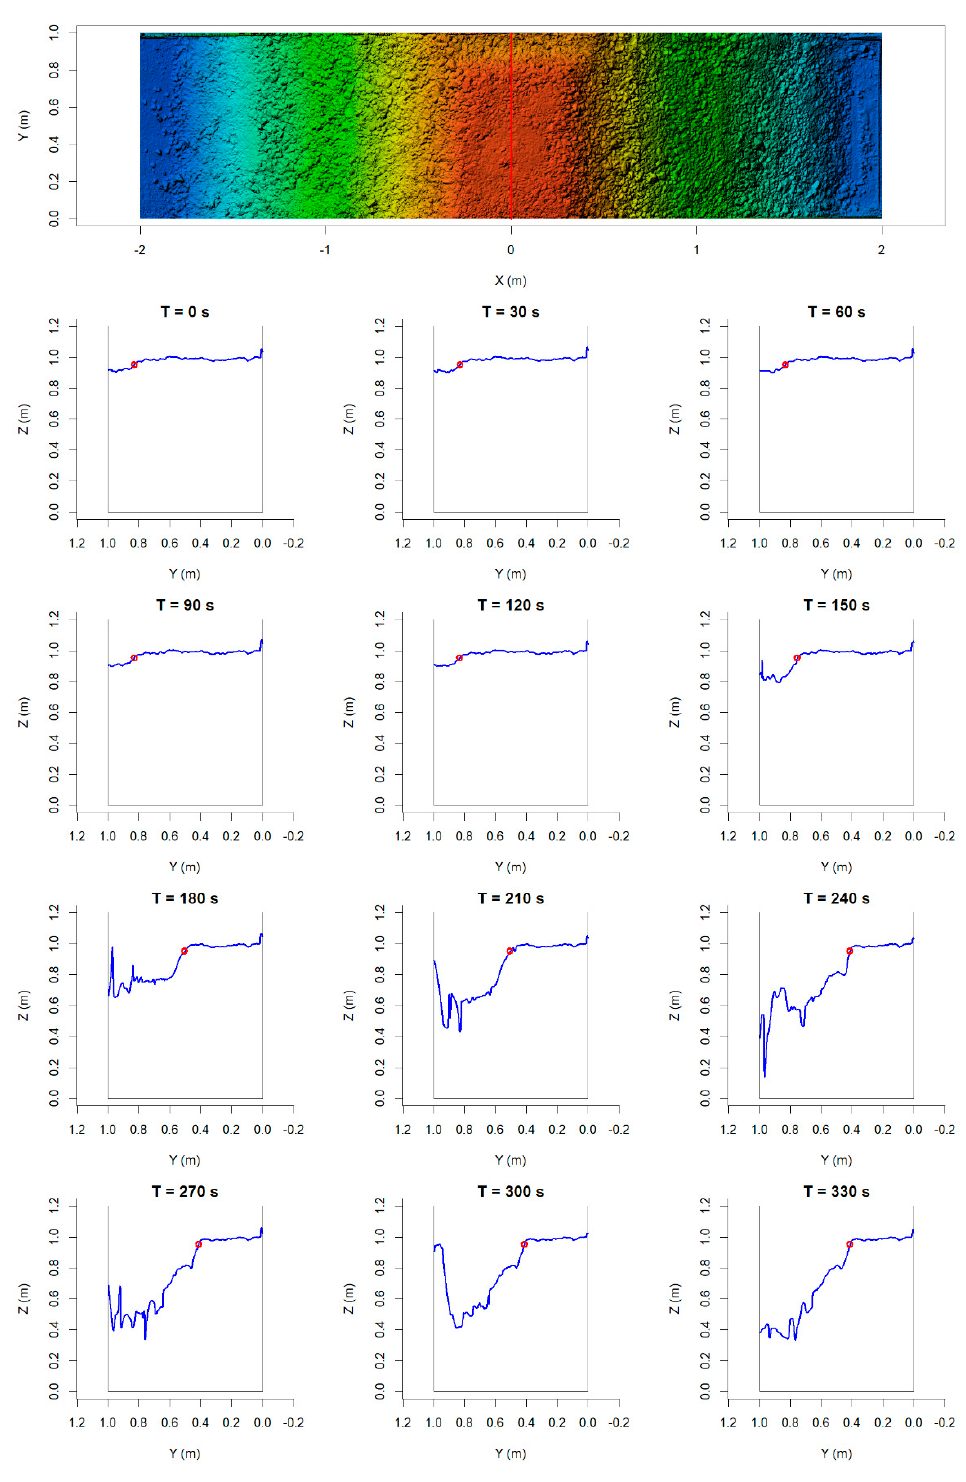
Figure 12. Cross-section profiles for X = 0 m (centre line) extracted from U4 (central core) dynamic 3D model; T = 0 s is immediately before initially observed erosion at the downstream edge of the crest; red circle indicates breach edge as used in further analyses.